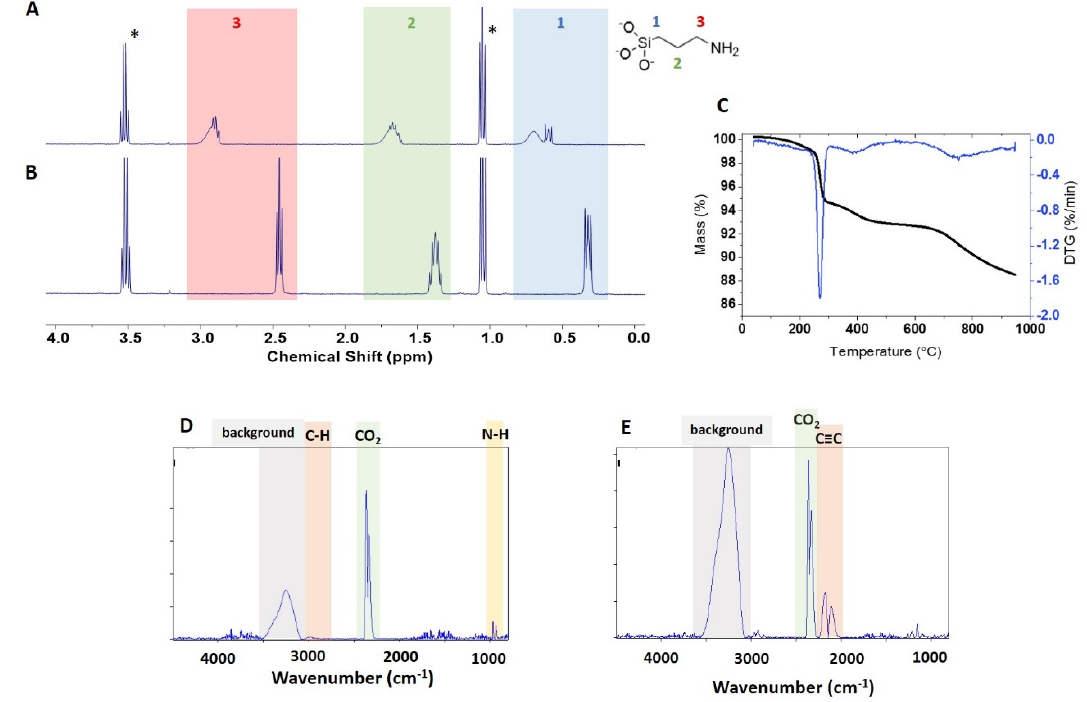
Figure 3. Characterisation of APTES functionalized ZnO sample USRN-05-NH 2 : ( A , B ) 1 H NMR spectra of 3-aminopropylsiloxane moiety after dissolution of the sample in 0.4 M DCl (A) or hydrolysis in 0.4 M NaOD ( B ), ( C ) representative thermogram and ( D , E ) FT-IR spectra of evolved gases measured at 345 ◦ C ( D ) and 744 ◦ C ( E ). The signals marked with an asterisk in (A) are due to ethanol. The grey shaded areas ( C , D ) are due to background caused by ice condensation in the detector.